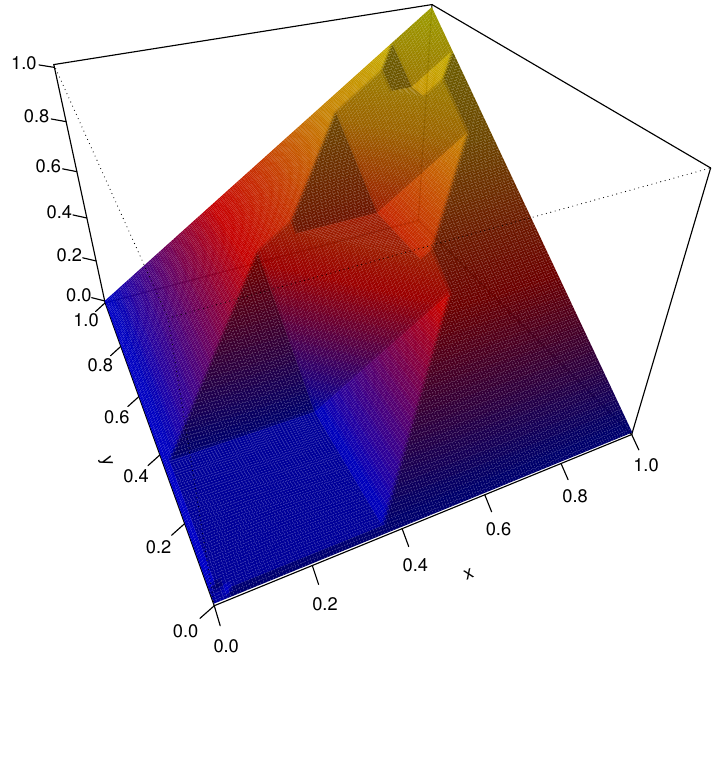
Figure 4: The (proper) quasi-copula A δ for δ as in Figure